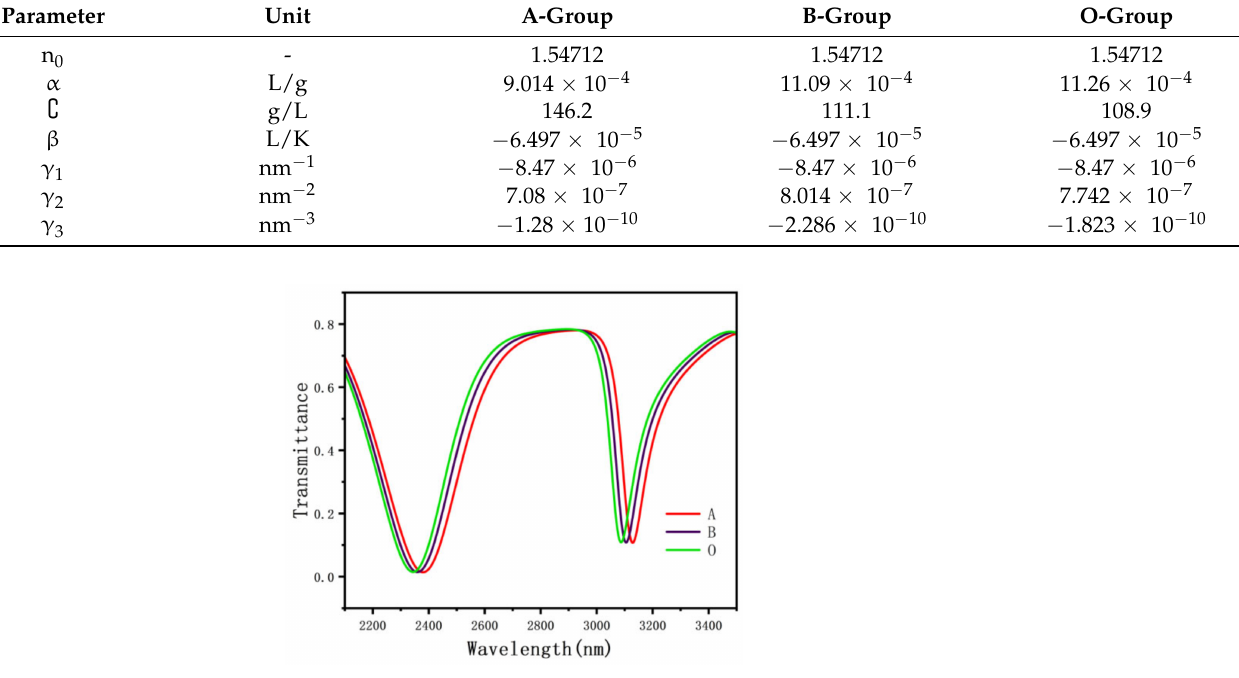
Figure 12. The transmission spectrum of different blood